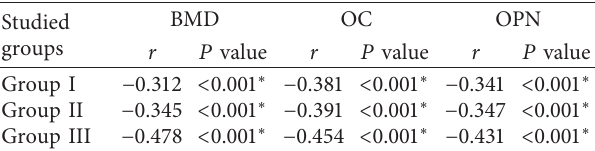
Table 2: The correlations of HbA1c level versus BMD, OC, and OPN in the studied